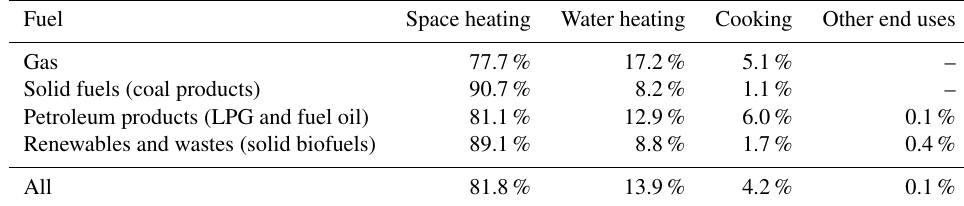
Table 5. Share of final energy consumption in the residential sector by fuel and type of end use in Europe (Eurostat,